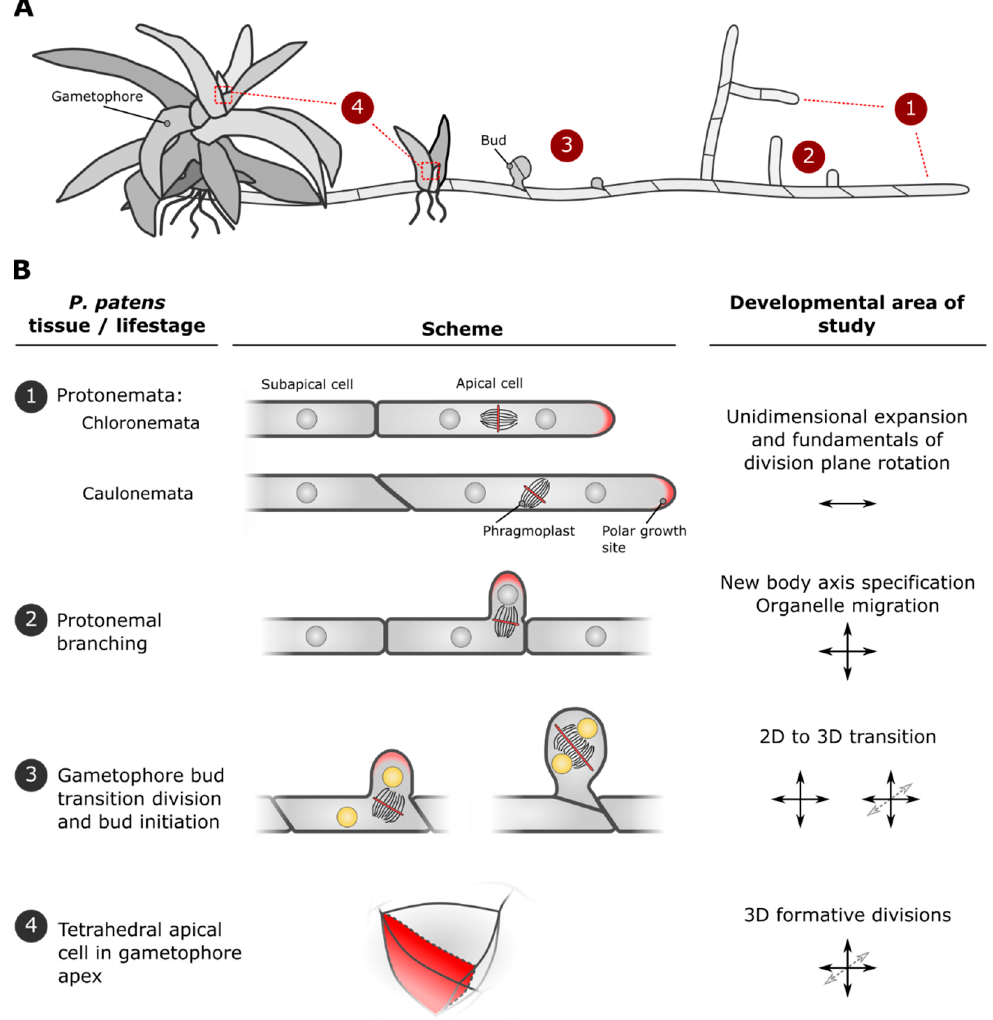
Figure 2. Developmental progression in Physcomitrium patens and the accompanying cellular phenomena that can be studied. ( A ) Schematic overview of stages in P. patens (gametophytic) development. Cellular outlines (protonemata/buds) or tissue outlines (gametophores) are depicted. Tissue types predominantly associated with juvenile up to adult phases are arranged right to left. Numbers correspond to particular tissues and/or life stages, with oriented cell divisions leading to tissue type specification or changes in growth axes that are further detailed in B. ( B ) Four P. patens tissues/life stages where various aspects of cell division plane orientation and the establishment of new organismal axes can be studied: (1) Two types of filamentous protonemata (chloronemata + caulonemata) both grow by polarized, unidimensional cell expansion at their apex. The former produces division planes (red line) perpendicular to the growth axis, while the latter exhibits tilting of the division apparatus (phragmoplast), leading to slanted division planes. (2) A secondary growth axis (indicated by arrows) within protonemal tissue can be established by branching of subapical cells. This involves cell polarization and control over nuclear position and division plane orientation. (3) From the juvenile protonema, a transition to 3D developing gametophores can be initiated. This starts by outgrowth of a bud accompanied by cell divisions with specific division plane orientations that establish new organismal axes. Initiation of this developmental program is regulated by distinct transcriptional and hormonal pathways (indicated by yellow nuclei). (4) The apex of the bud ultimately gives rise to a singular stem cell with three cutting faces (one is indicated). Its continued production of daughter cells and their further developmental trajectories drive gametophore